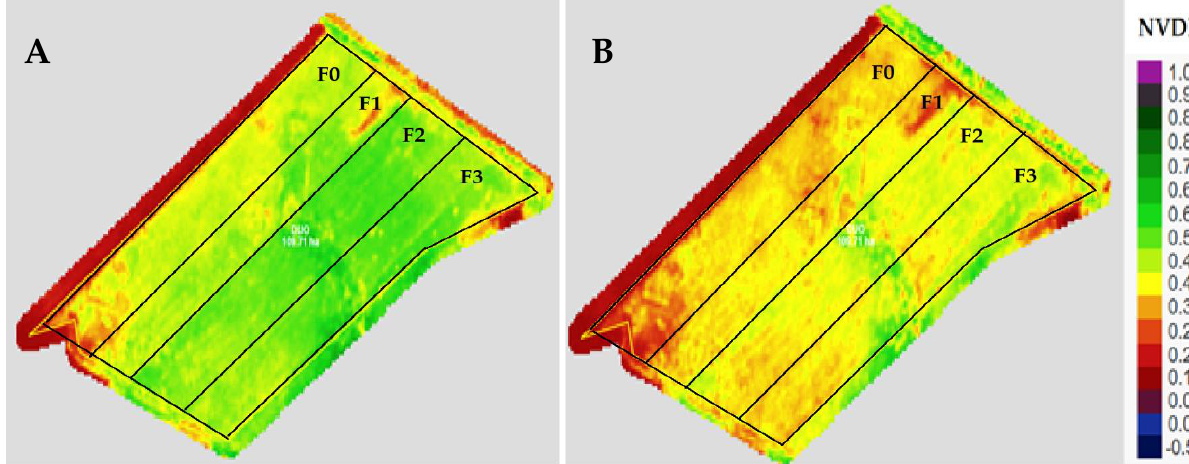
Figure 7. Map with the vegetation index (NDVI) for August 31 ( A ) and September 11 ( B ). Note: F0 — control; F1 — foliar fertilization; F2 — localized fertilization: microgranules for precision application into the soil; F3 — localized fertilization: microgranules for precision application into the soil with foliar fertilization.